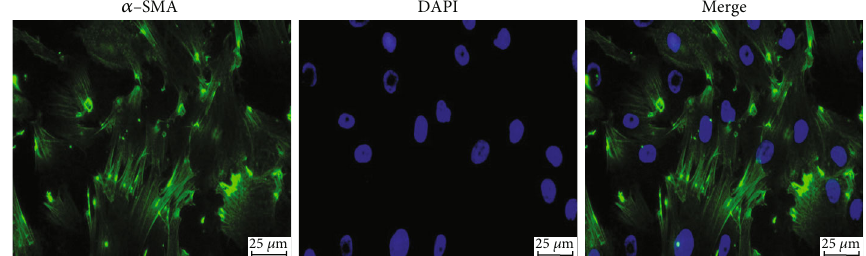
Figure 2: The identi fi cation of isolated aortic VSMCs using the immuno fl uorescence staining of VSMC-speci fi c marker of α -SMA. Nuclei were stained with DAPI. Scale bar = 25 μ m